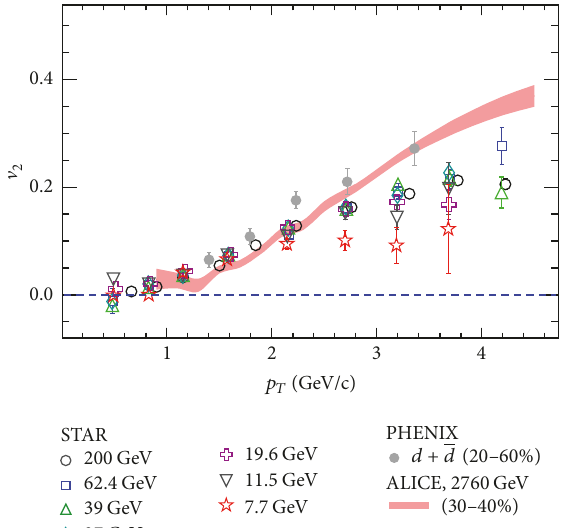
Figure 3: Energy dependence of midrapidity V 2 (𝑝 𝑇 ) of 𝑑 for minimum bias (30–40% for ALICE) collisions.